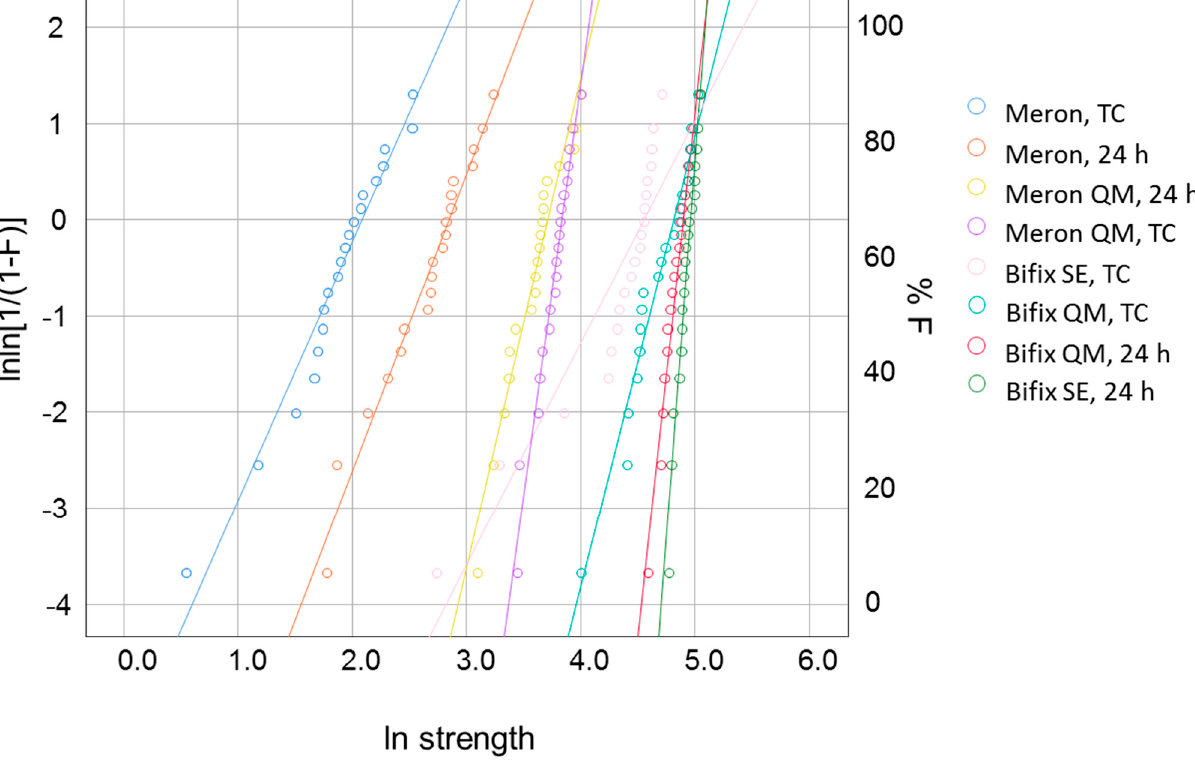
Figure 2. Weibull distribution as a function of luting material and aging conditions.